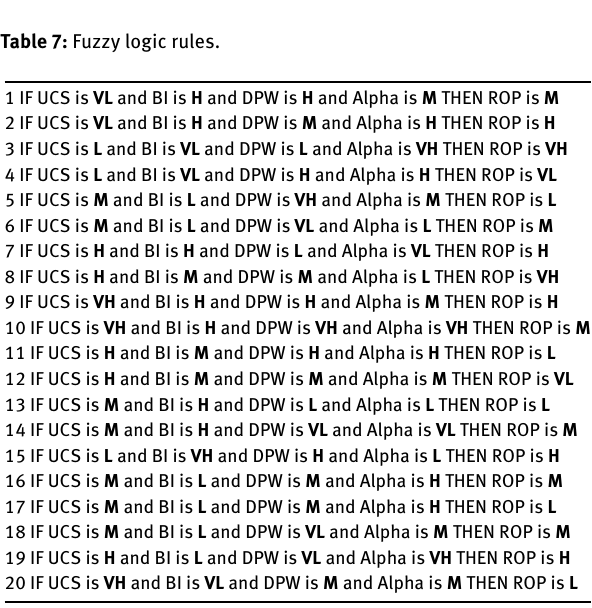
Table 7: Fuzzy logic rules.